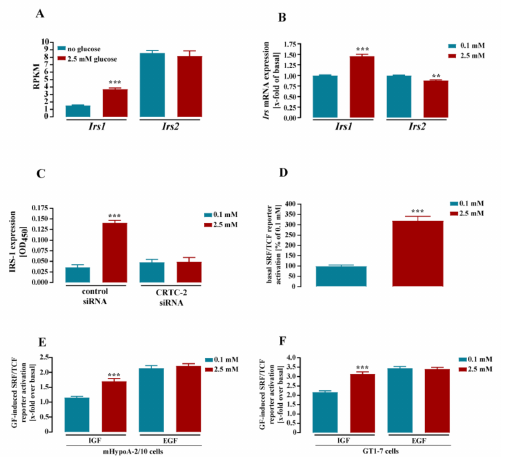
Figure 7. Glucose enhanced IRS-1 expression via CRTC-2 and IGF- but not EGF-induced activation of an SRF/TCF-dependent luciferase reporter gene. mHypoA-2/10 cells were stimulated